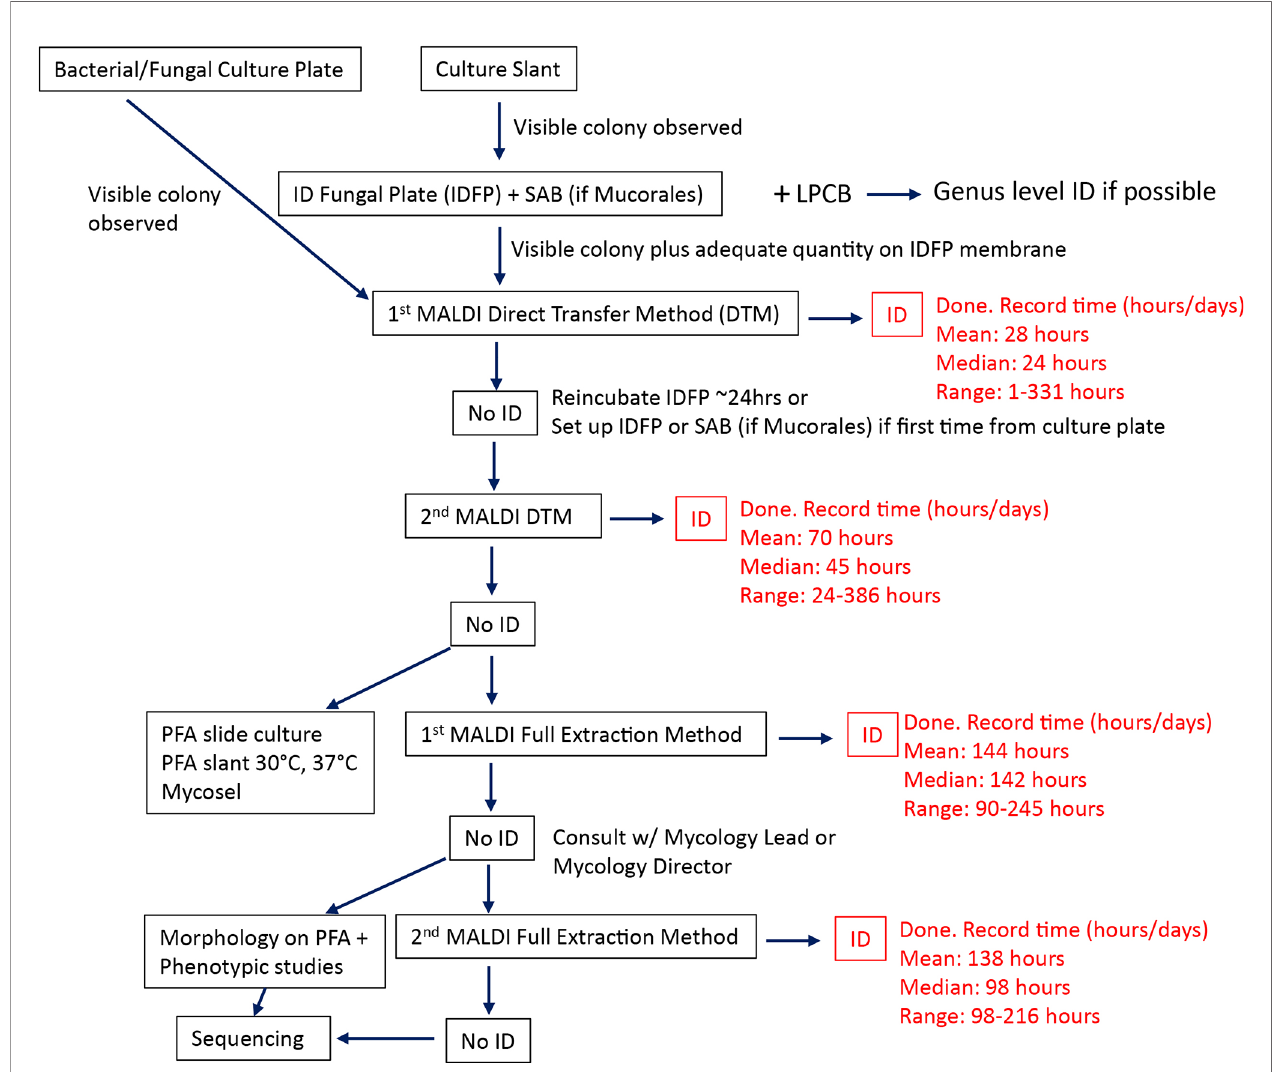
FIGURE 1 | Rapid MALDI-TOF MS identi fi cation algorithm. Traditional mycology workup is supplemented by two rounds of MALDI-TOF MS using the direct transfer method followed by two more attempts of using MALDI-TOF MS broth full extraction method. The mean, median, and range provided for each MALDI-TOF step is based on the results of this study. SAB, Sabouraud agar; PFA, Potato fl ake agar; LPCB, Lactophenol Cotton Blue wet